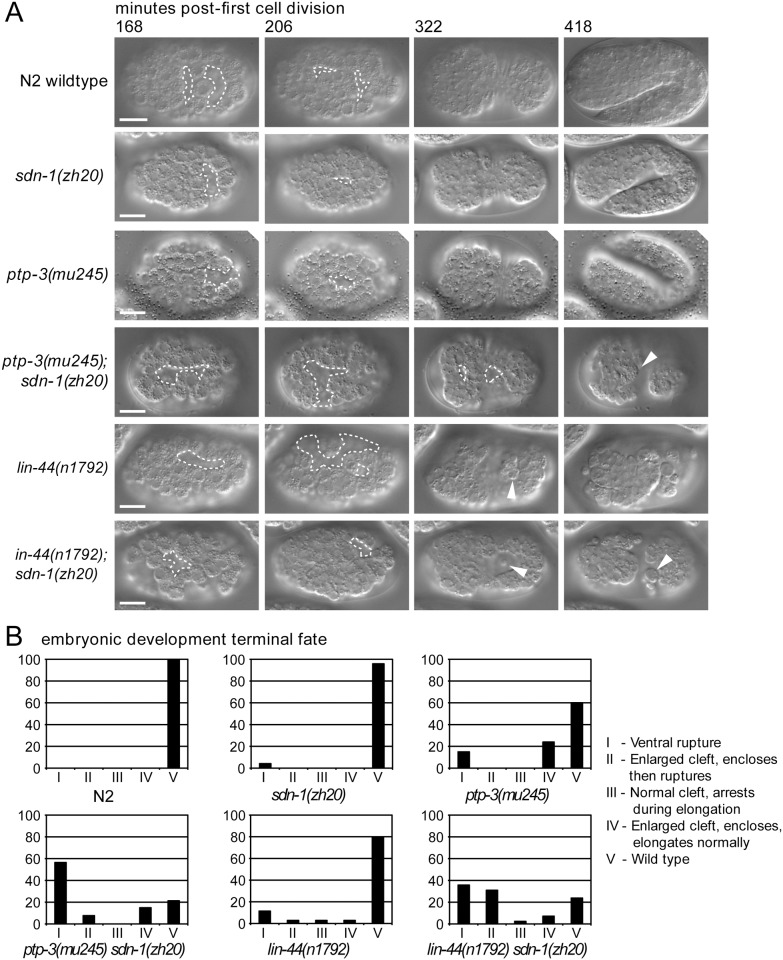
The dual loss of ptp-3 and sdn-1 results in synergistic defects during embryogenesis.A: Using 4D time-lapse microscopy we monitored embryogenesis in N2 wild-type, ptp-3, sdn-1, lin-44 single mutants, and lin-44; sdn-1 and ptp-3; sdn-1 double mutants. The gastrulation clefts (outlined regions) present in the single mutants are more likely to close during development than the clefts in the double mutants. The arrowhead indicates cells that have extruded from the internal region of the embryo through the open gastrulation cleft (panel 418 minutes). B: Terminal fates of the embryos plotted by genotype.